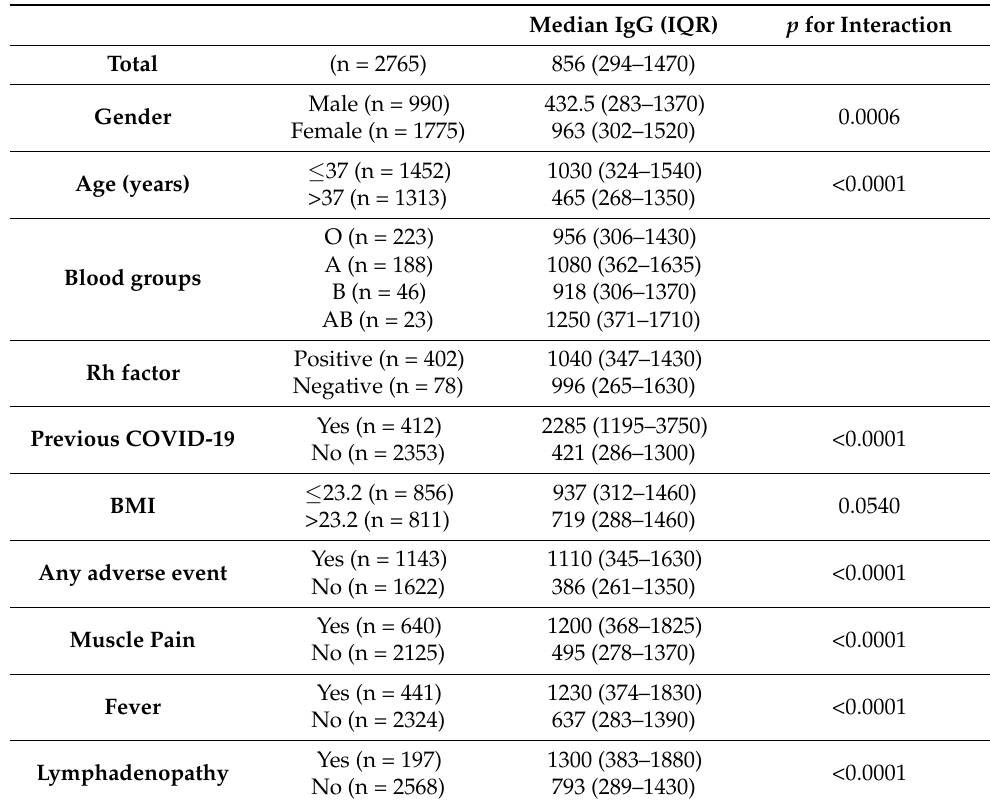
Table 3. IgG titers (AU/mL) following two doses of SARS-Cov-2 vaccine based on subject features and reported adverse events; the Mann–Whitney test was